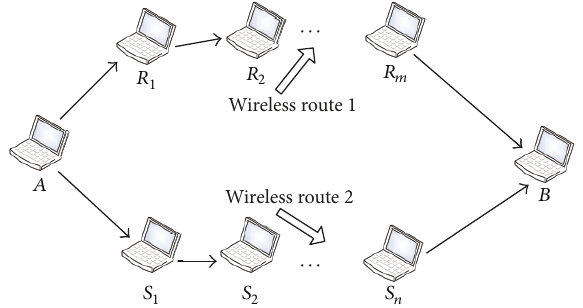
Figure 3: Disjoint routes between 𝐴 and 𝐵